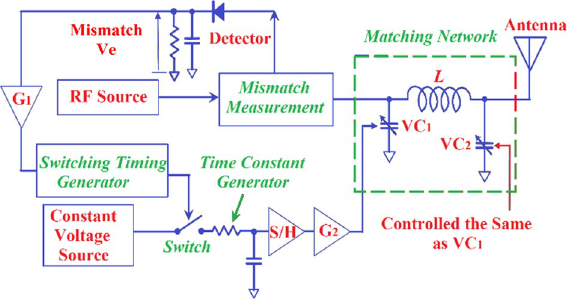
Figure 1. Configuration of the proposed adaptive matching